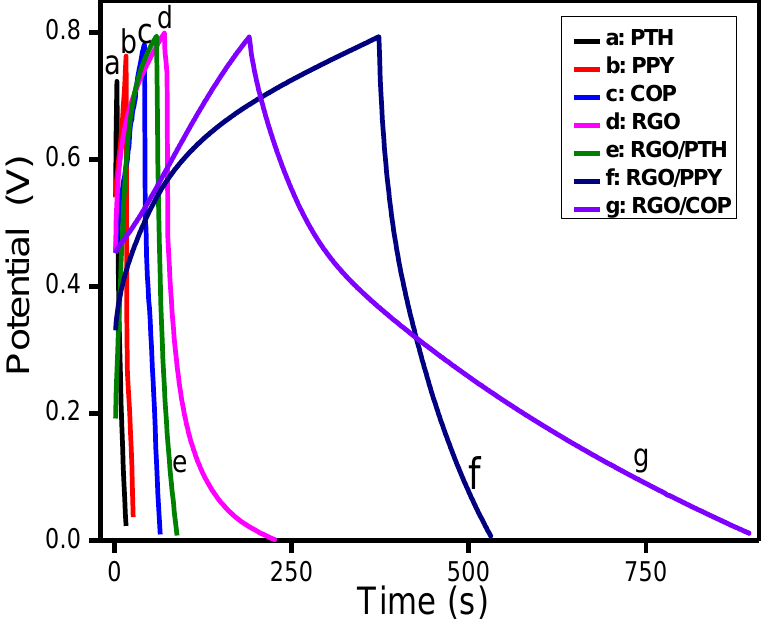
Figure 10. Galvanostatic charge discharge (GCD) curves of ( a ) PTH, ( b ) PPY, ( c ) COP, ( d ) RGO, ( e ) RGO/PTH, ( f ) RGO/PPY, and ( g ) RGO/COP at a current density of 0.81 A/g.